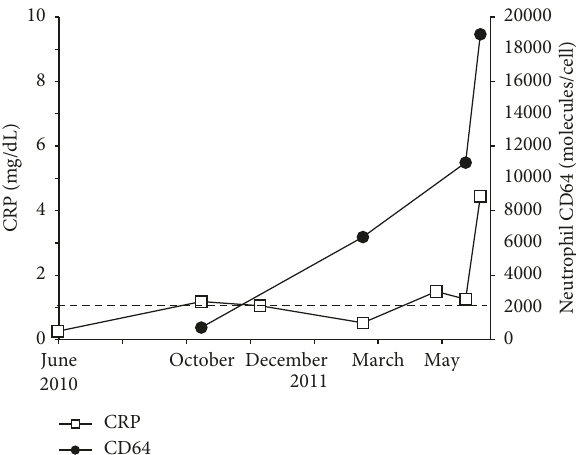
Figure 3: Levels of neutrophil CD64 increased even after antibiotic therapy (case 2).